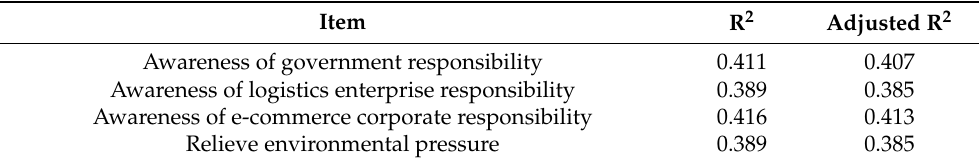
Table 15. R 2 test of four latent